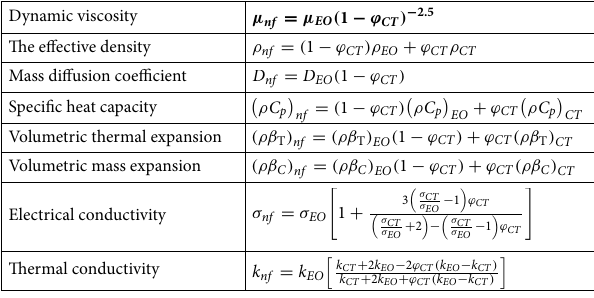
Table 1. Nanofluid correlations are given as 41–46 .